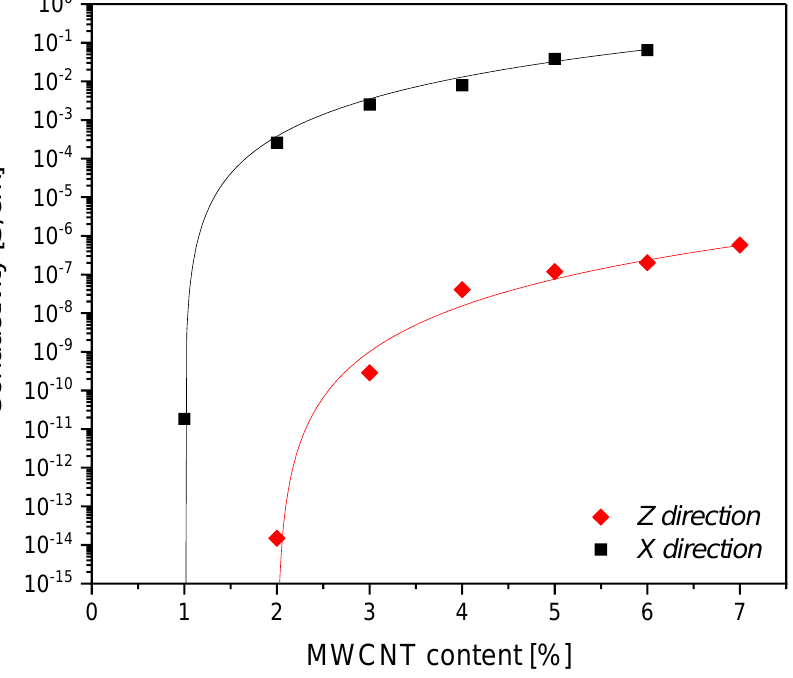
Figure 2. Percolation curves in X and Z directions: experimental data and fitting curves.